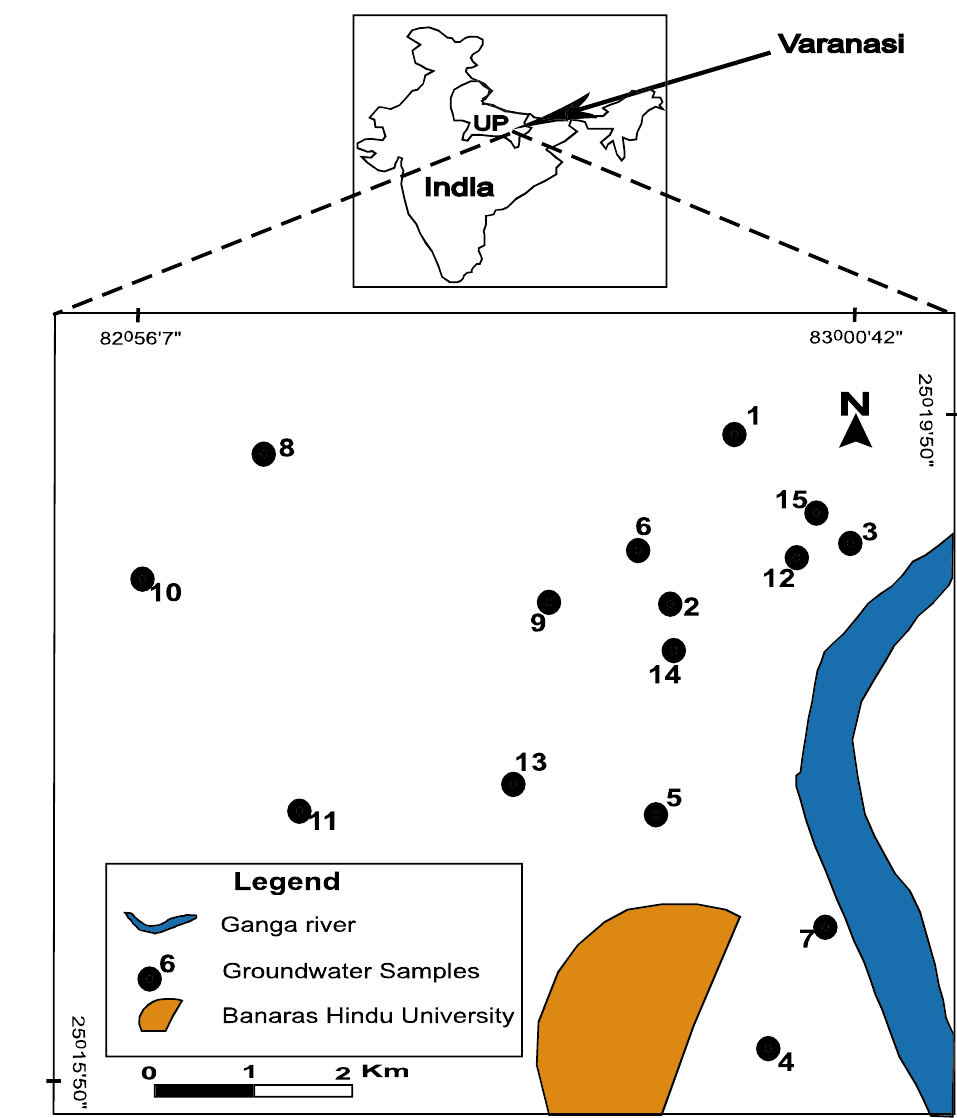
Fig. 1 Physiographic and sampling locations map of the study area